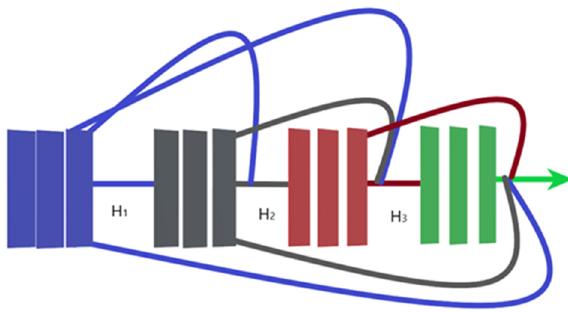
Figure 6. Three-layers dense block.